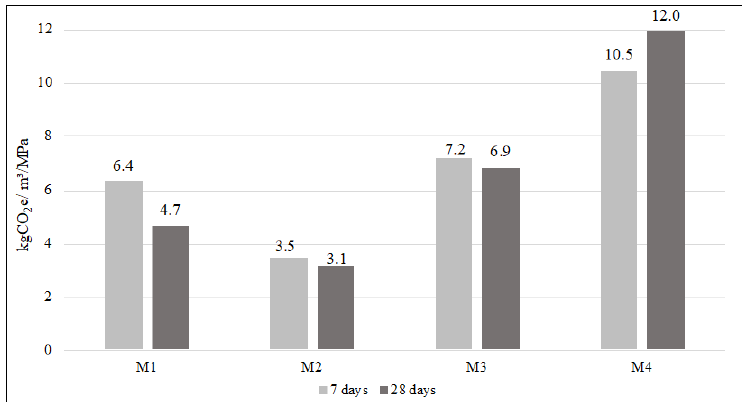
Figure 7. kg CO 2 e/m 3